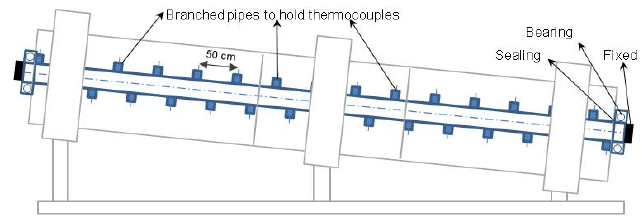
Figure 4. Position of thermocouples inside the gasifier.